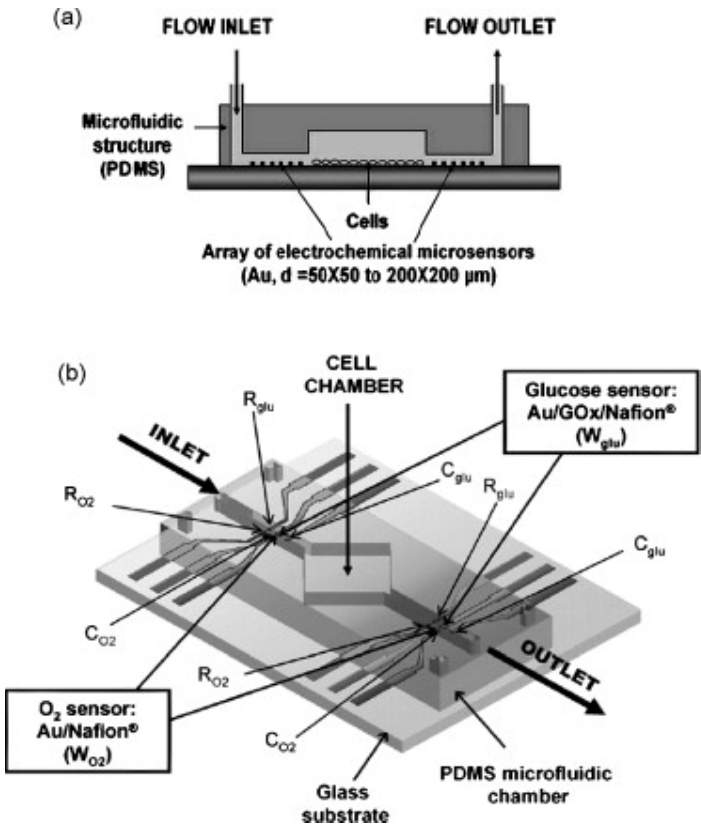
Figure 6. ( a ) Cross-section and ( b ) general schematic view of the developed biochip composed of two arrays of glucose and oxygen electrochemical microsensors integrated at the inlet and outlet microchannels of a PDMS microfluidic chamber. (Copyright 2008. Reprinted from [33] with permission from